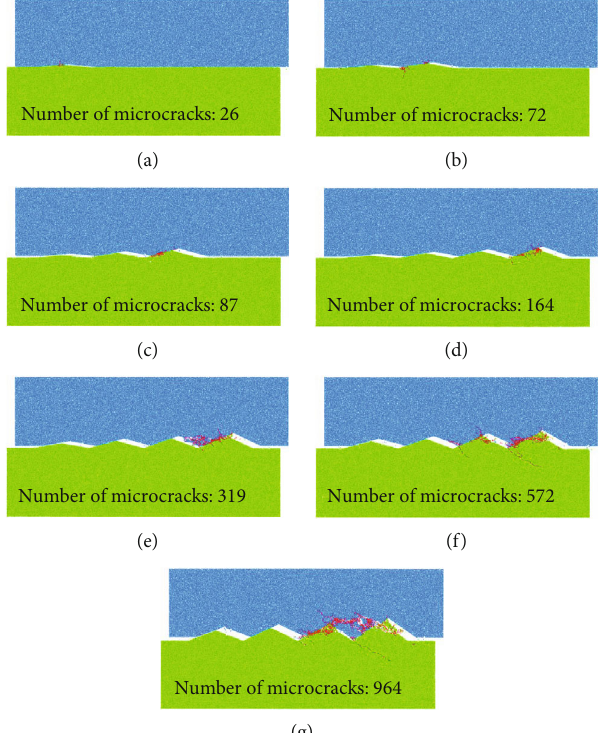
Figure 9: Failure diagram of joint sample with di ff erent levels of roughness: (a) joint 1; (b) joint 2; (c) joint 3; (d) joint 4; (e) joint 5; (f) joint 6; (g) joint 7.